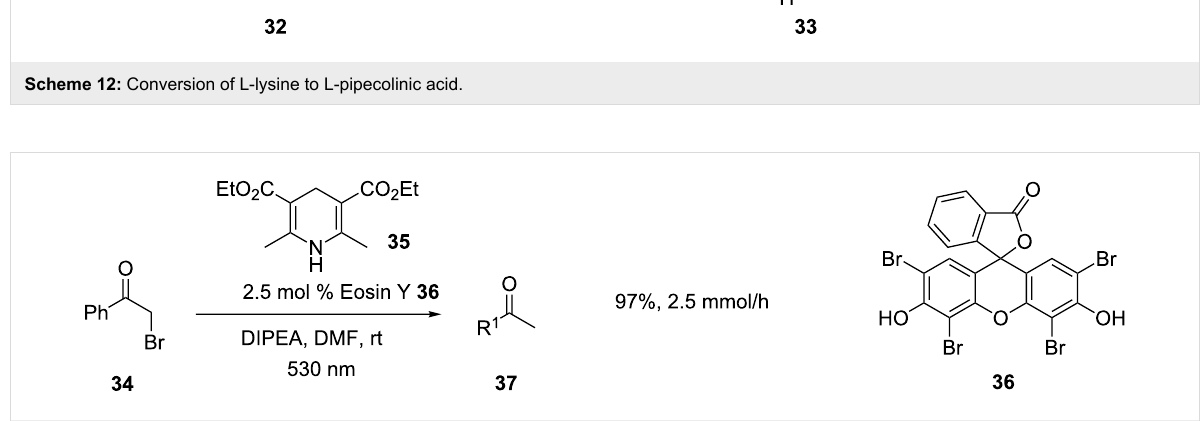
Scheme 13: Photocatalytic